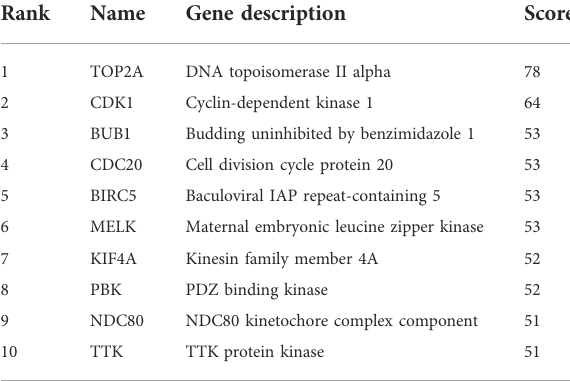
TABLE 3 Top ten hub genes with a higher degree of